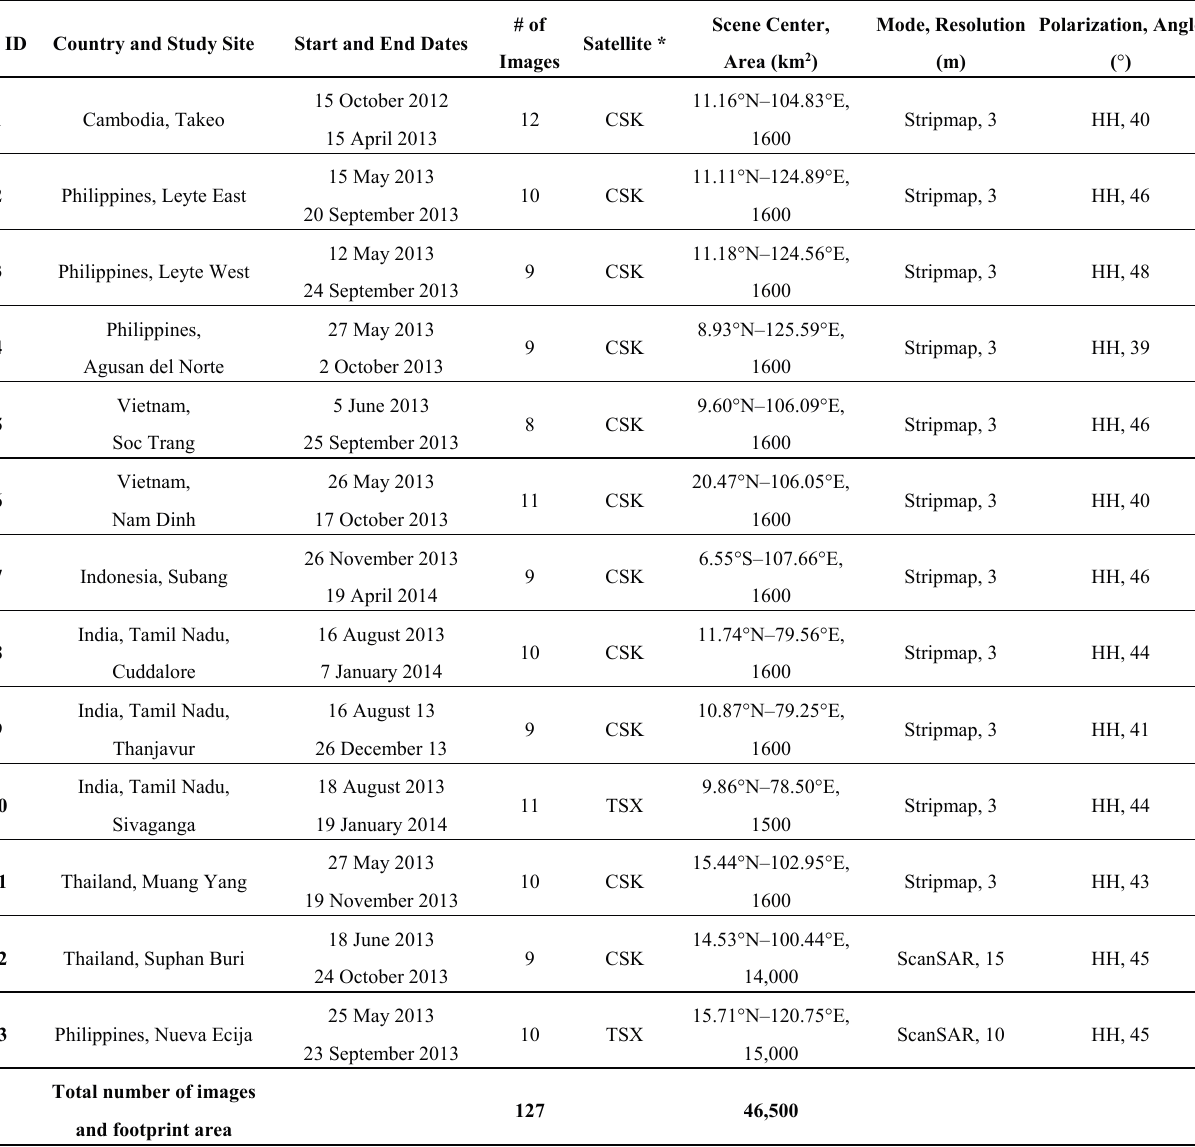
Table 1. SAR data acquisition summary: locations, dates and modes. Further details on the acquisitions for each site are included in the Supplemental Information section. CSK, COSMO-SkyMed; TSX,